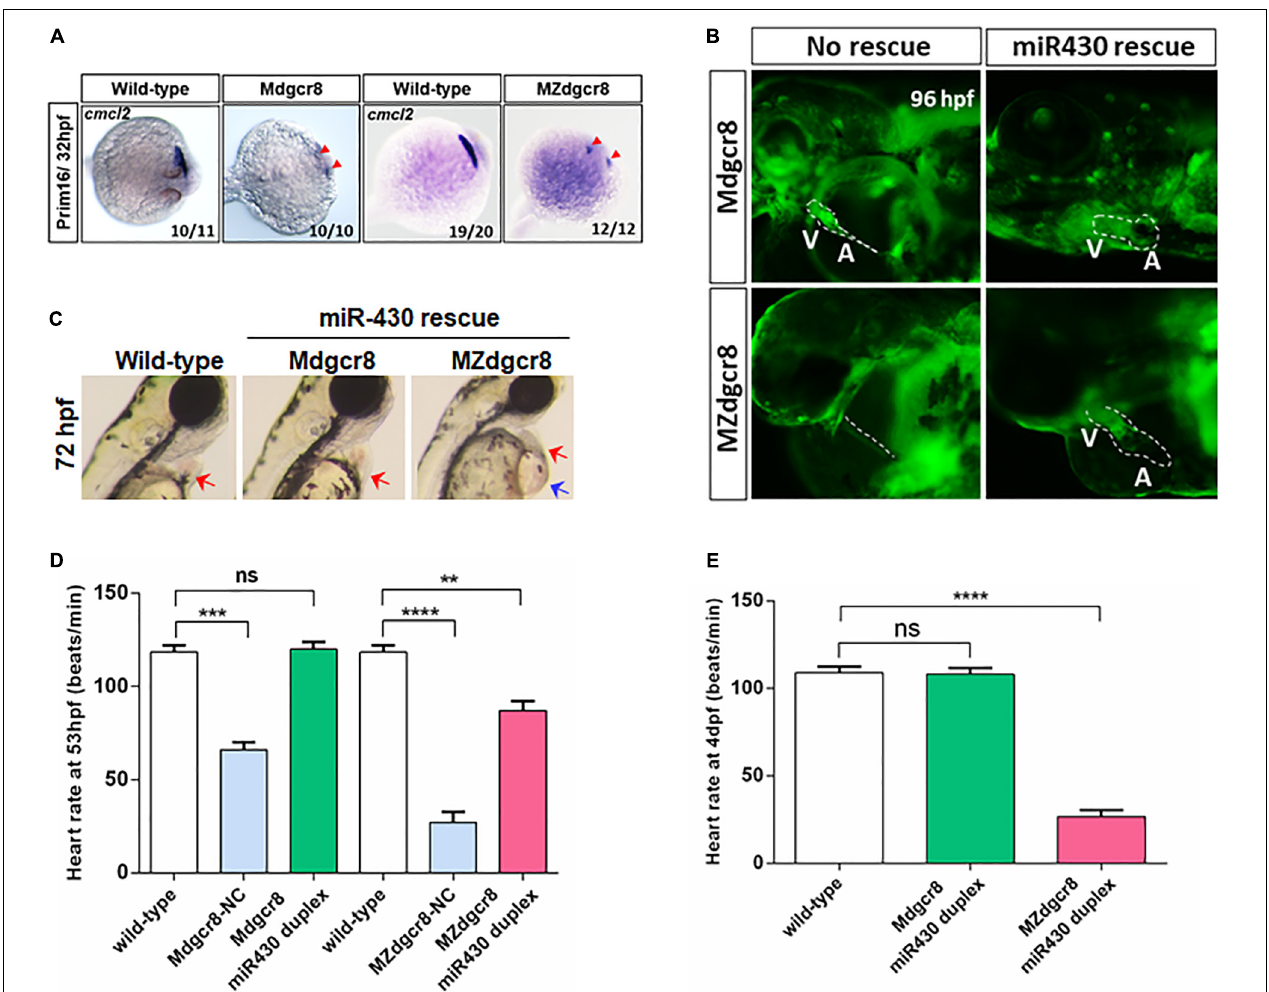
FIGURE 4 | Heart defects was successfully rescued in M dgcr8 , but not in MZ dgcr8 . (A) The cardiac progenitor cells failed to migrate to the middle-line at prim-16 stage (32 hpf) in M dgcr8 and MZ dgcr8 (red arrows). (B) After miR430 rescue, cardiogenesis appeared normal including structure of atrium and ventricle. (C) MZ dgcr8 failed to be rescued by mir430, exhibiting hydropericardium phenotype. (D,E) Heart-rate results indicated that the heart defects were completely rescued in M dgcr8 , but only partially in MZ dgcr8 , and MZ dgcr8 heart rate gradually decreased at 4 days. ** p < 0.01, *** p < 0.001, and **** p < 0.0001.